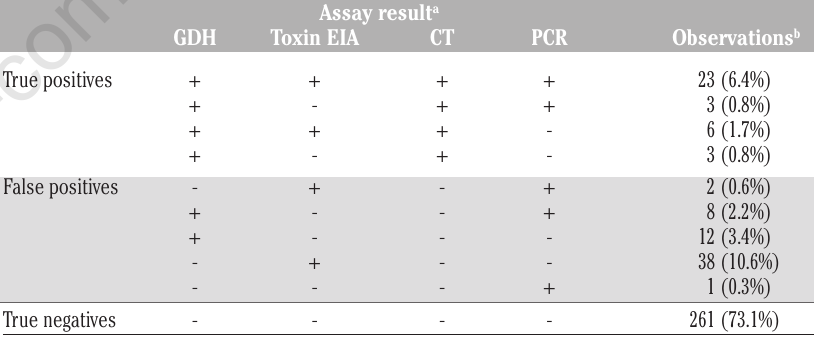
Table 1. Aggregate results of stool samples evaluated by each C. difficile testing modality.